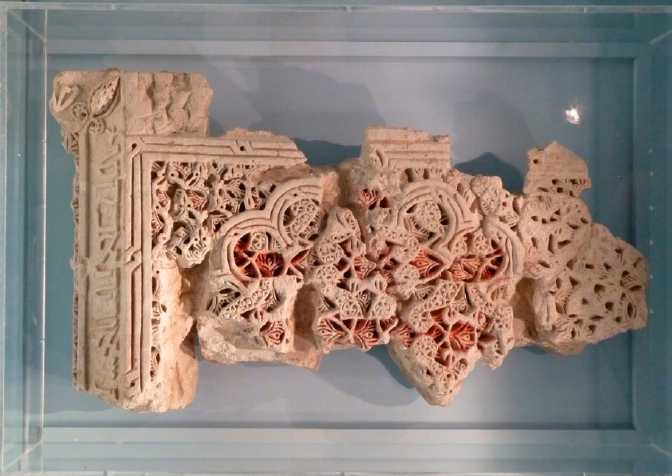
Figure 15. Decorative panel of the heikhal of Molina de Aragón Synagogue. Author’s photo.